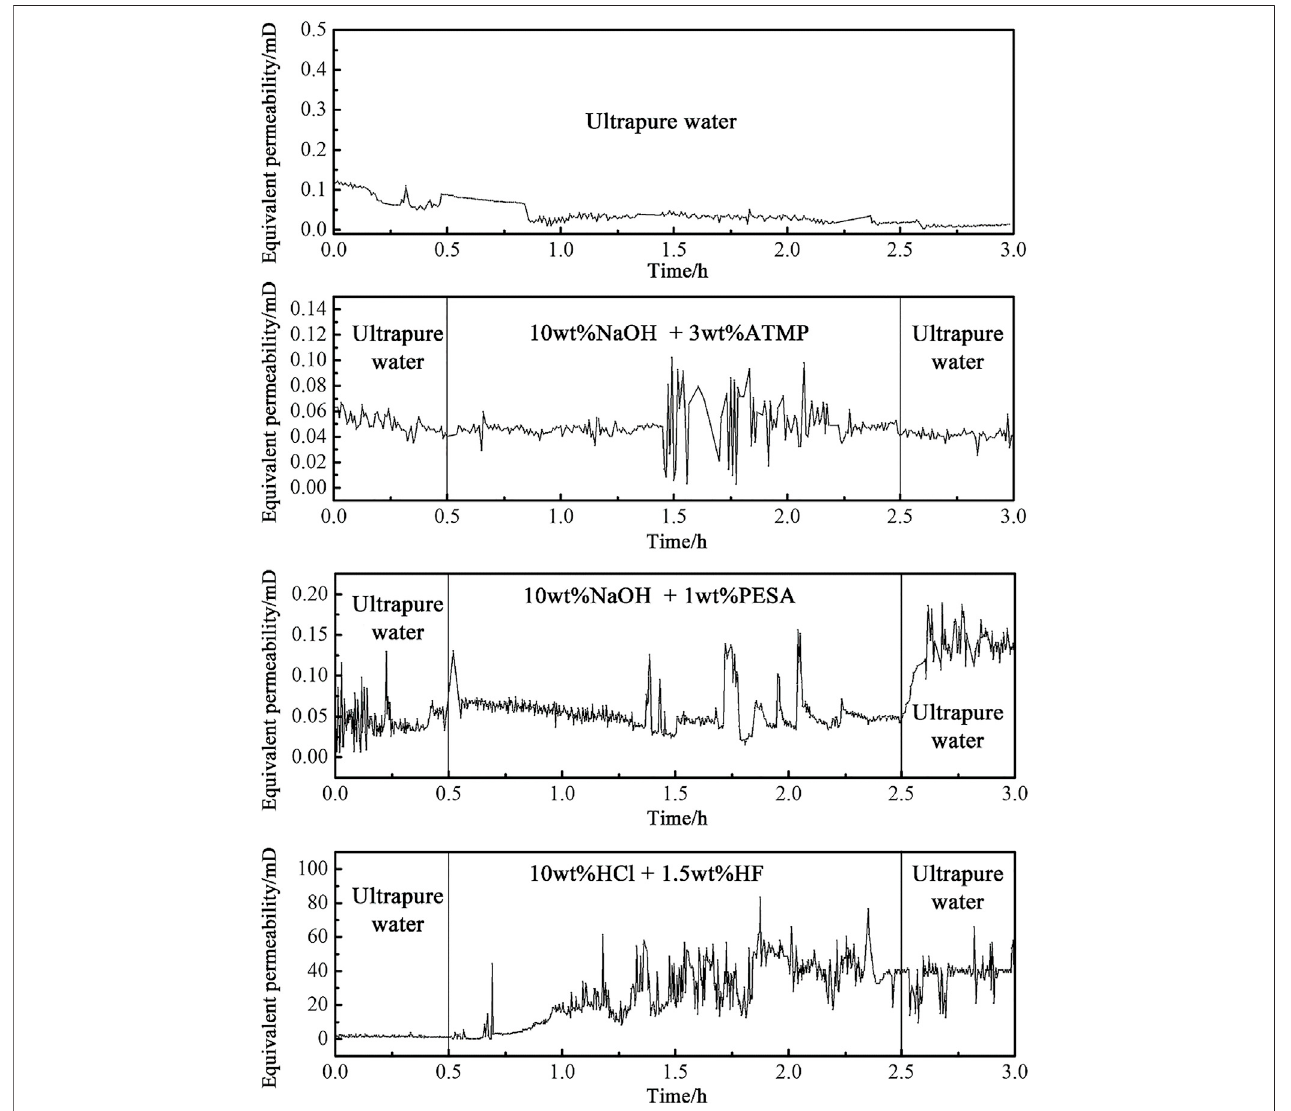
FIGURE 5 | Change of equivalent permeability of the cores with